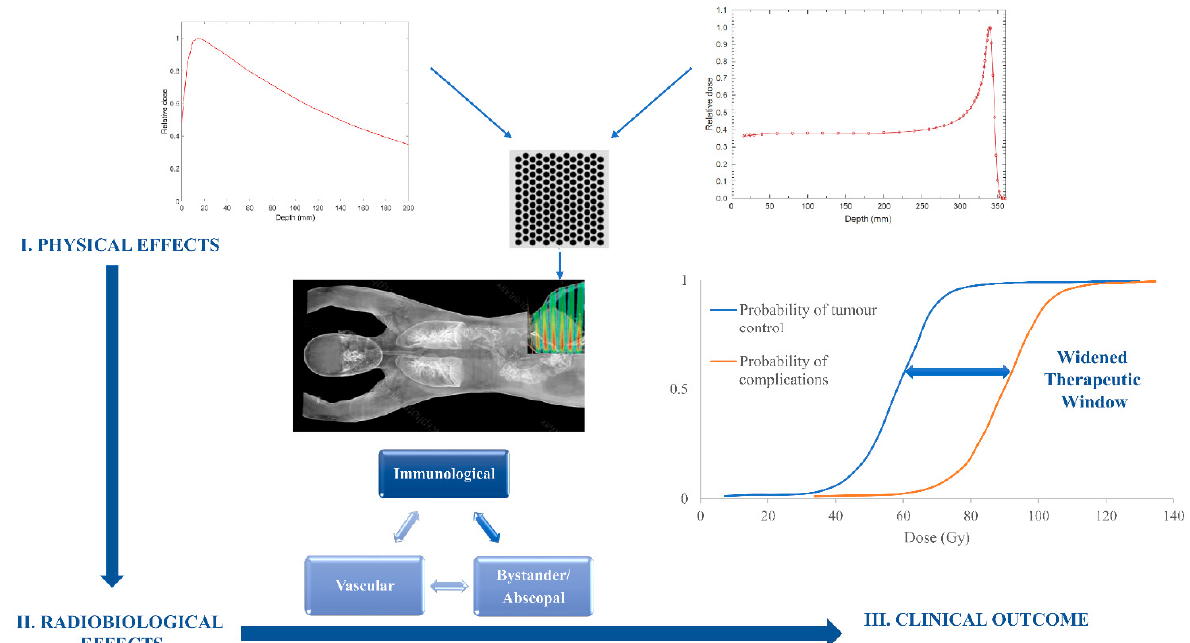
Figure 1. Schematic representation of the physical, radiobiological, and clinical effects concerning spatially fractionated radiotherapy delivered via photon or proton beams.